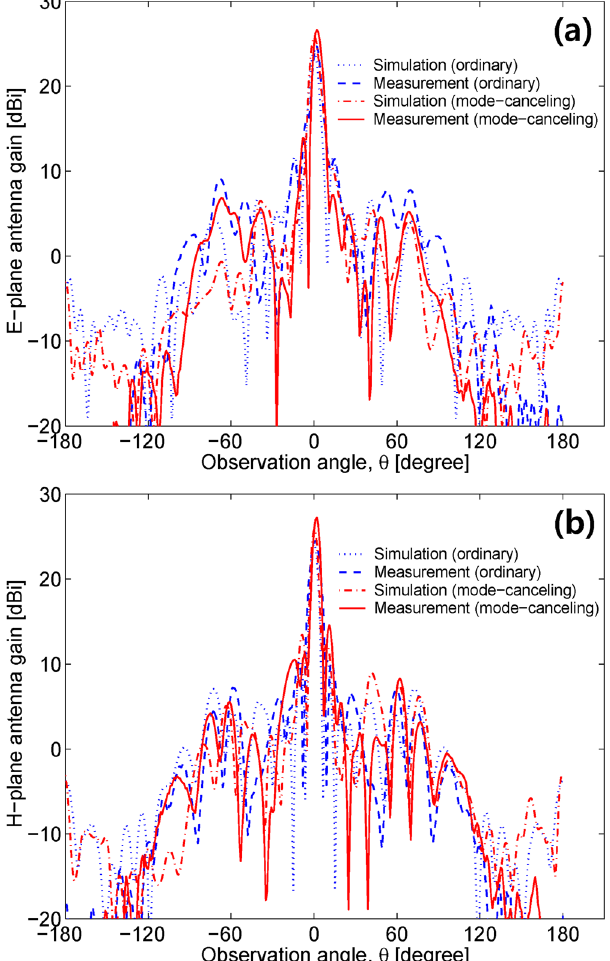
= = ) and mode-canceling main sub